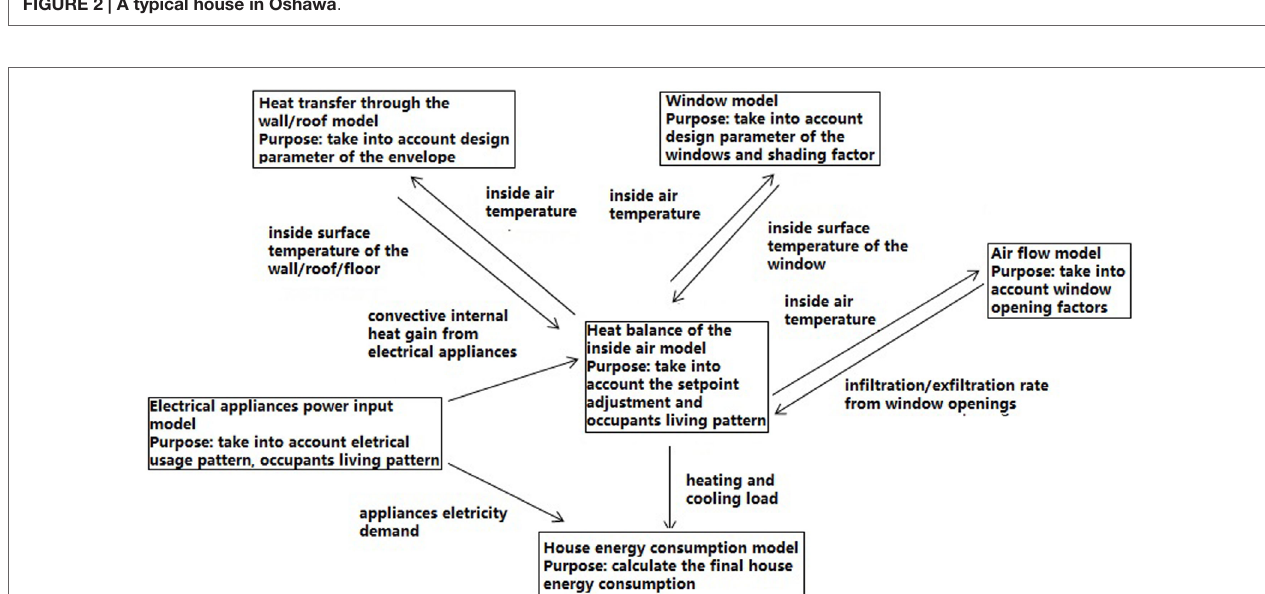
FigUre 3 | Overview of the relationships among the models